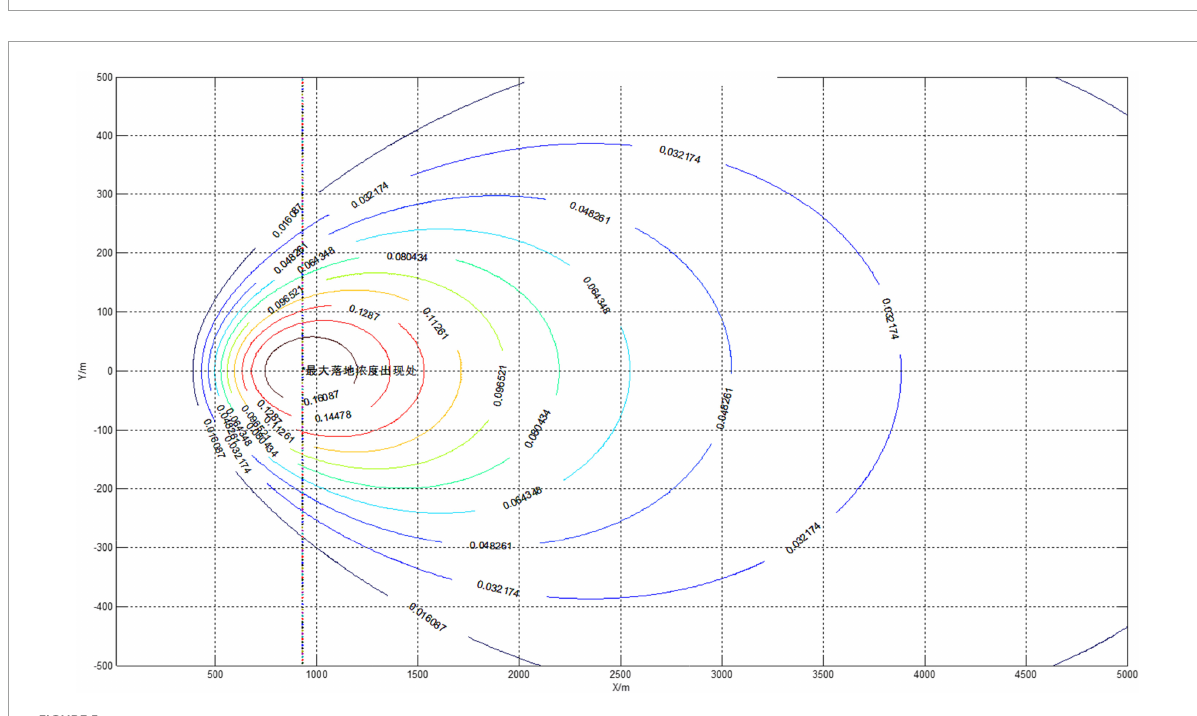
FIGURE4 Contour map in N direction.